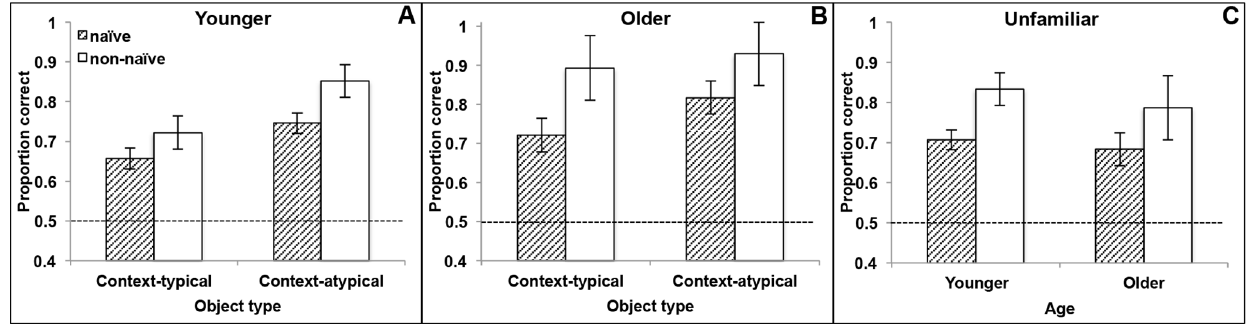
Figure 5. Mean recognition accuracy. (A) (B): Accuracy for context-typical and context-atypical objects for younger and older adults, shown separately for testing naı¨ve and non-naı¨ve participants; (C): accuracy for unfamiliar objects for younger and older adults, shown separately for testing naı¨ve and non-naı¨ve participants. Bars show standard errors of the mean; dashed line indicates chance performance.